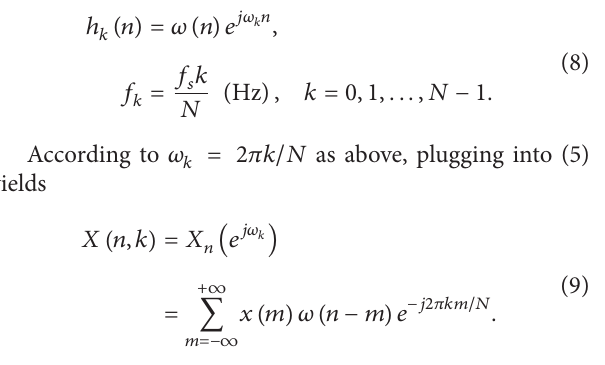
Figure 4: Structure of